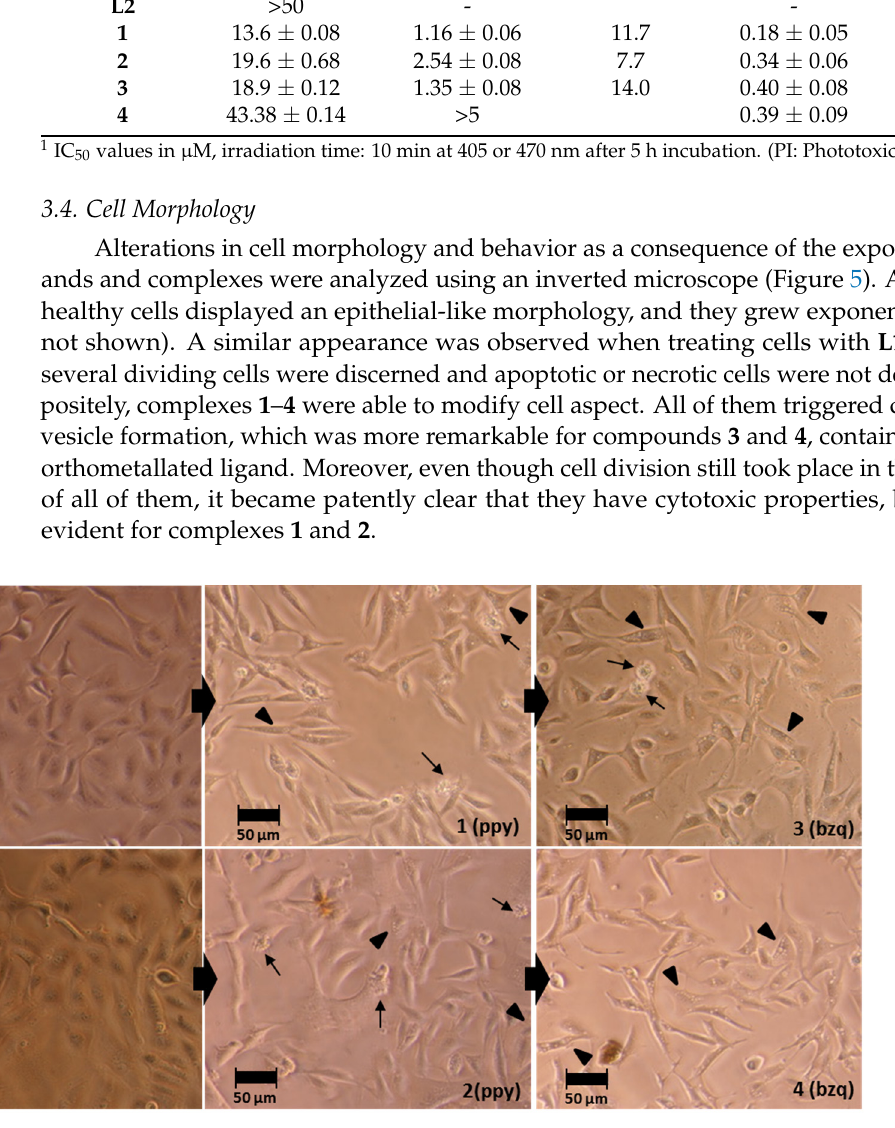
Figure 5. Phase contrast microscopy images of A549 cells treated with L1 , L2 and 1 – 4 at concentrations between 10 and 20 µM for 20 h. Black arrows point to apoptotic cells. Little black triangles show examples of cells containing cytoplasmic vesicles.